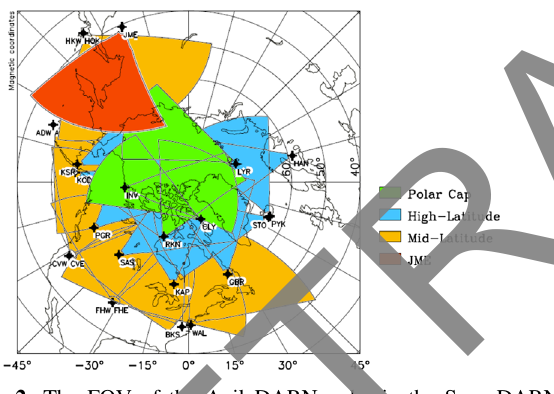
Figure 2. The FOV of the AgileDARN radar in the SuperDARN network. The FOV of the AgileDARN radar (JME) along with the other Northern Hemisphere SuperDARN radars in operation. The FOV for the AgileDARN radar is shaded red, and the FOVs for the other middle-latitude, high-latitude, and polar cap radars are shaded yellow, blue, and green, respectively. The FOVs are plotted in geomagnetic